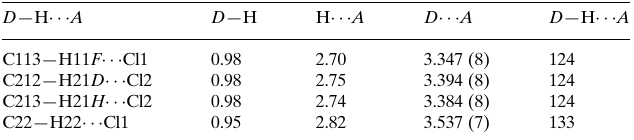
Hydrogen-bond geometry (A˚ , (cid:2)